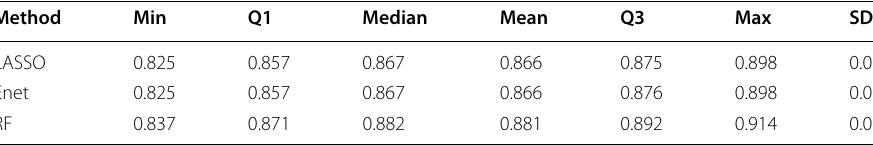
RF, random forest; Q1, quartile 1; Q3, quartile 3